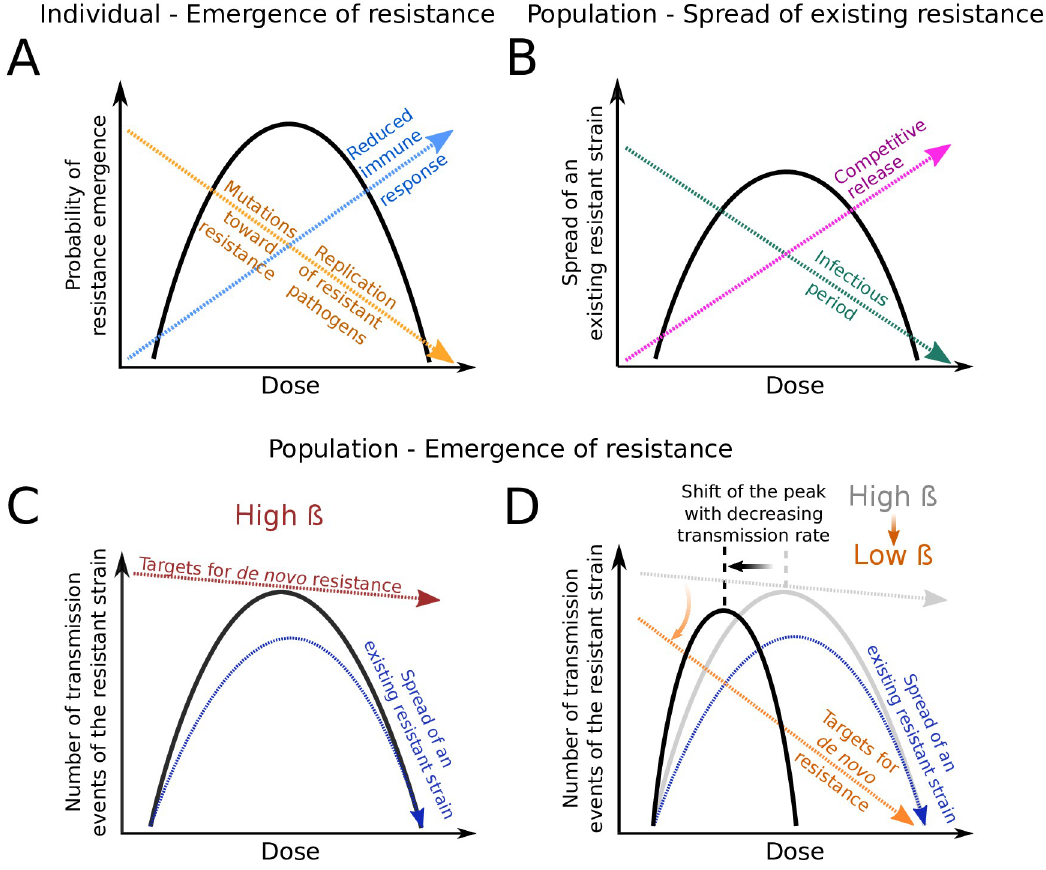
Fig 8. Risk of resistance and the factors shaping it at the individual and population levels. ( A ) The within-host probability of resistance emergence (solid black line) is shaped by three forces that are in part inversely affected by the drug dose: the strength of the immune response triggered by the sensitive strain (dashed blue arrow), the mutations of sensitive-to-treatment pathogens towards resistance during treatment (dashed orange arrow) and the rate of clearance of the resistant strain through the drug (dashed orange arrow as well). This panel is based on Figure 1 from Kouyos et al. [5] and adapted to represent the scenario we model. ( B ) The spread of an existing resistant strain in a susceptible population (solid black line) also has an inverted U-shape. Increased drug pressure favors the spread of a resistant strain through competitive release (dashed pink arrow). However, with increasing dose, the infectious period (dashed green arrow) decreases, even for infections with the resistant strain. ( C,D ) Number of transmission events of the resistant strain, at a high (C) or low (D) transmission coefficient β . This measure (solid black lines) depends on the ability of a resistant strain to spread (dashed dark-blue arrows, see panel B), and on the rate of de novo development of a resistant infection. This latter rate depends on the number of sensitively infected patients (or “targets for de novo resistance”), which in turn depends not only on the drug dose but also on R 0 . With a large R 0 , large outbreaks of the sensitive strain guarantee a high probability of appearance of resistance (red dashed line in Fig 8C). In contrast, for low R 0 , this probability severely decreases with increasing drug dose (dashed orange arrow in Fig 8D). The location of the peak in the number of transmission events of the resistant strain therefore depends on the transmission coefficient of the disease. The black curve is essentially the product of the red (or orange) arrow with the dark-blue arrow. The grey line and arrow in panel D are a repetition of the red arrow and black line in panel